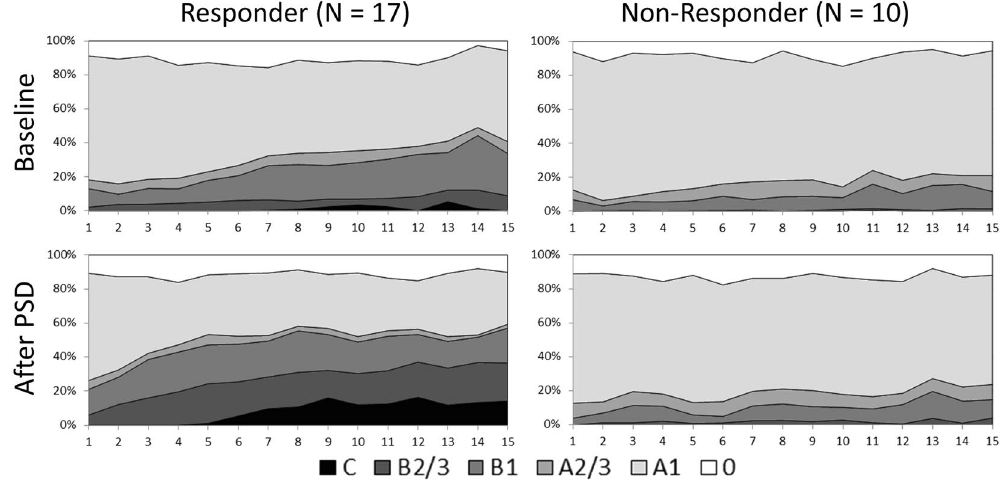
Figure 3. Time-course of EEG-vigilance stages during 15 minutes of resting EEG in responders and non-responders to sleep deprivation on day 1 (baseline, upper row) and day 2 (after sleep deprivation (PSD), lower